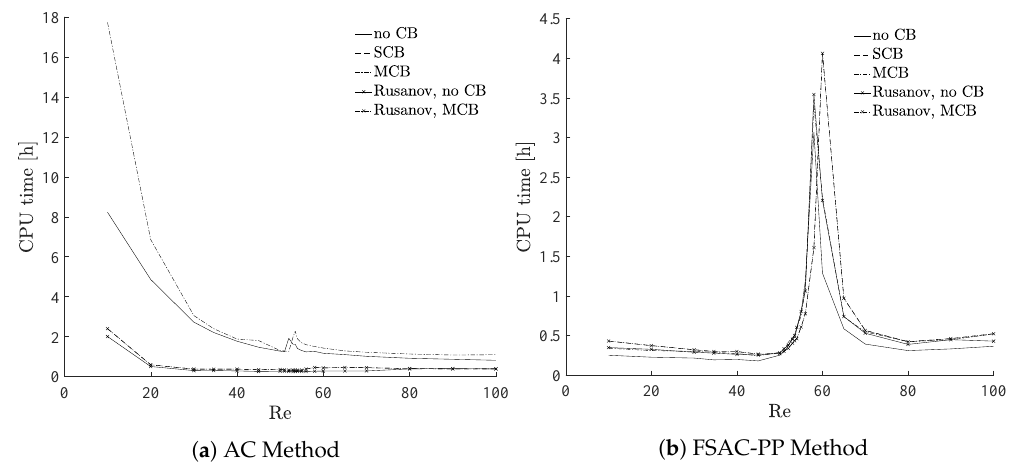
Figure 6. Total number of iterations required for the AC ( a ) and FSAC-PP ( b ) method for different Reynolnds